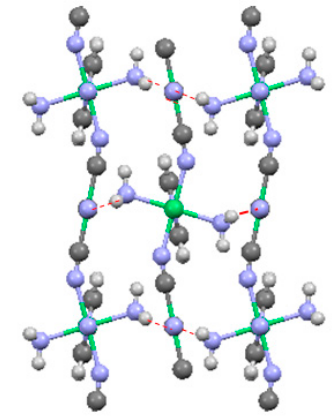
Figure 19. Terminal C ≡ N groups of the neighboring Ni-C-N-Ni-N-C-Ni chains in the Ni-Bpy structure forming a zigzag fashion (view along c -axis; C-grey, N-blue, Ni-green). The red broken lines indicate H-bonding.